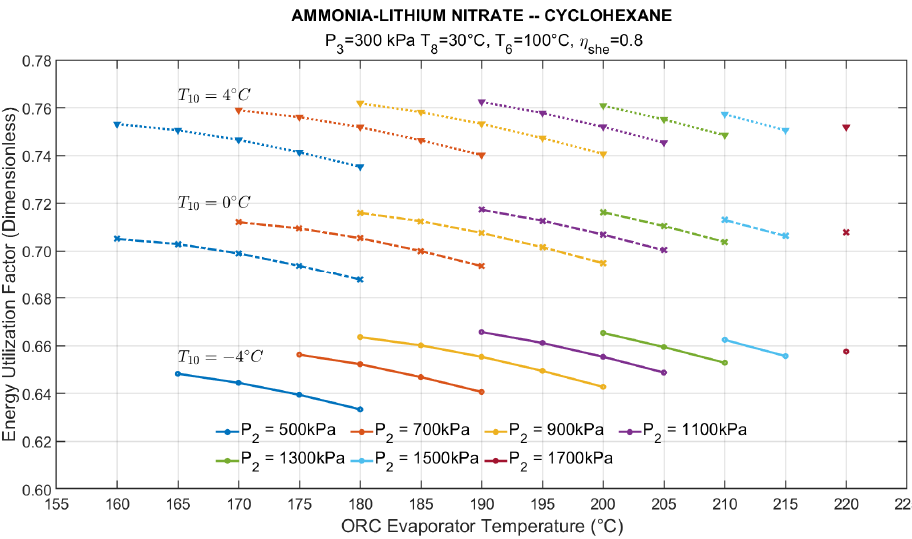
Figure 9. NH 3 -LiNO 3 --C 6 H 12 e ff ect of heat source and cooling temperatures on EUF.